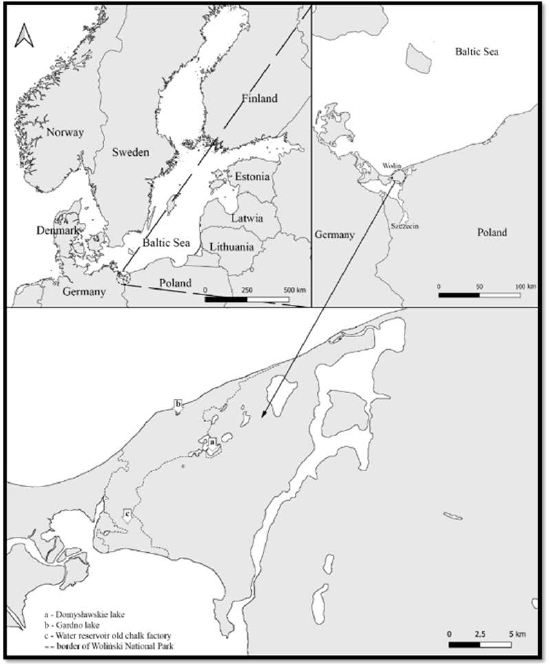
Figure 1. Location of the studied lakes in the Wolin National Park ((a)—Domysławskie Lake; (b)—Gardno Lake; (c)—Stara